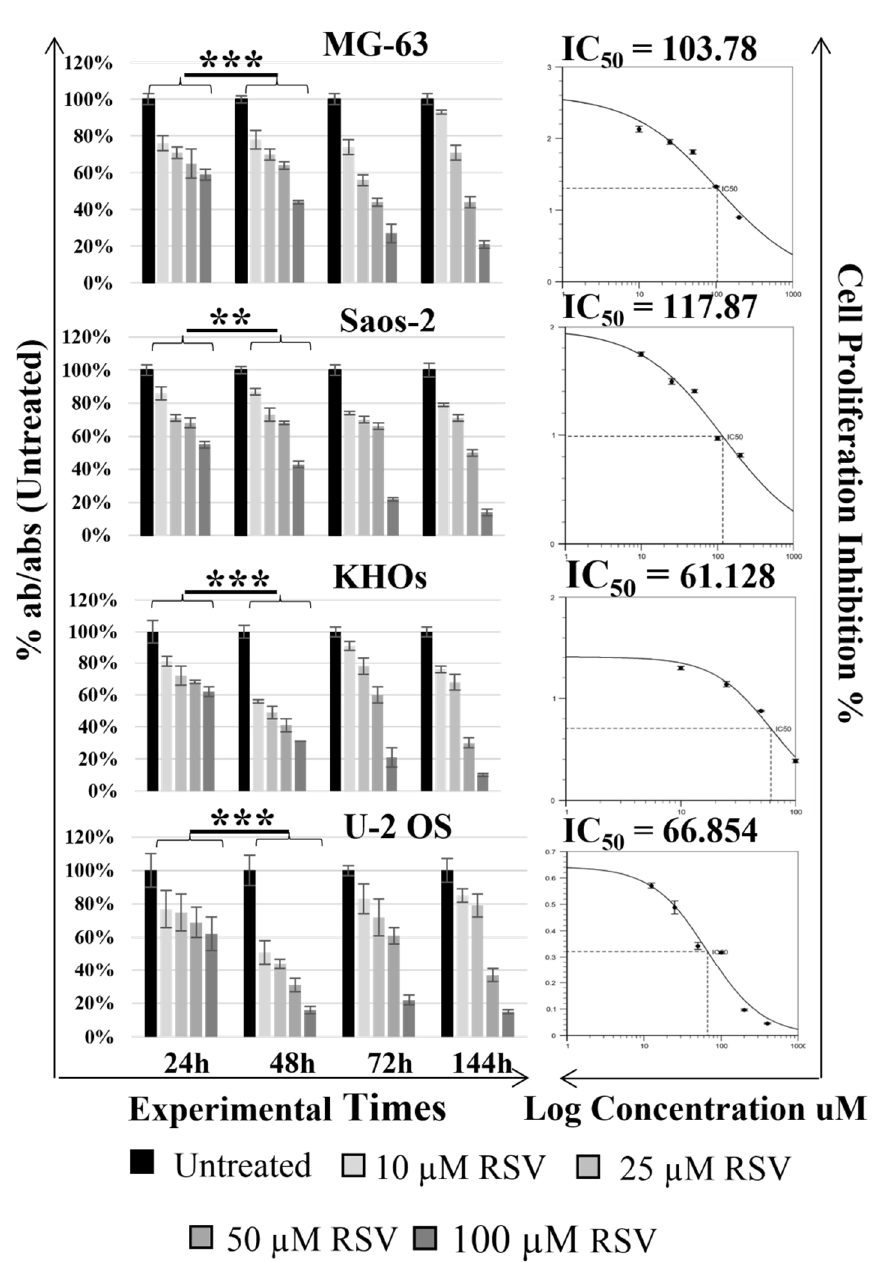
Figure 1. Effect of resveratrol on the cellular proliferation of OS cell lines. Cell viability was tested by WST-1 assay at various times after 48 h. As reported in each histogram, the absorbance values were converted into percentage absorbance values with respect to the untreated cells of each cell line. RSV treatment effects a significant reduction of cell proliferation after 48 h (** symbols correspond to p < 0.005 and *** symbols to p < 0.0005). All experiments were triplicated, with the data expressed as mean ± SD. On the right of each histogram are reported the graphs of the IC 50 values of RSV calculated for each cell line after 48 h. The IC 50 values were estimated by: https://www.aatbio.com/ tools/ic50-calculator-v1, accessed on 1 February